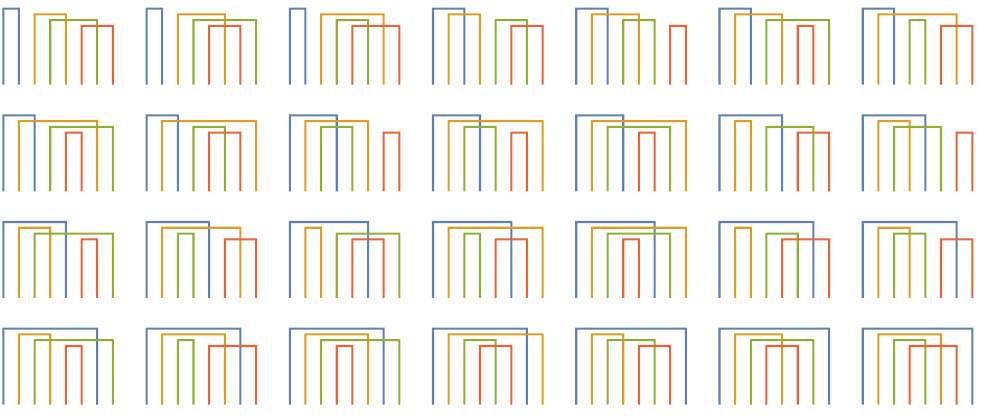
Figure 10 . The diagrams with two intersections contributing to the 8th